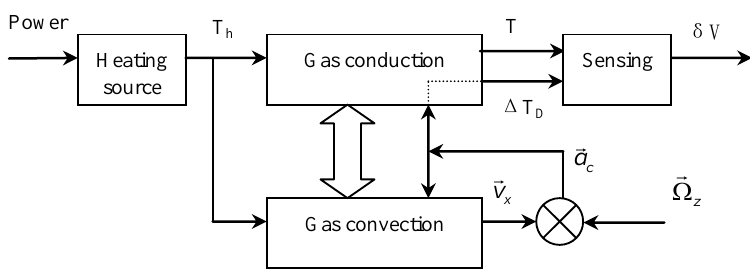
Figure 4. Block diagram of the sensor